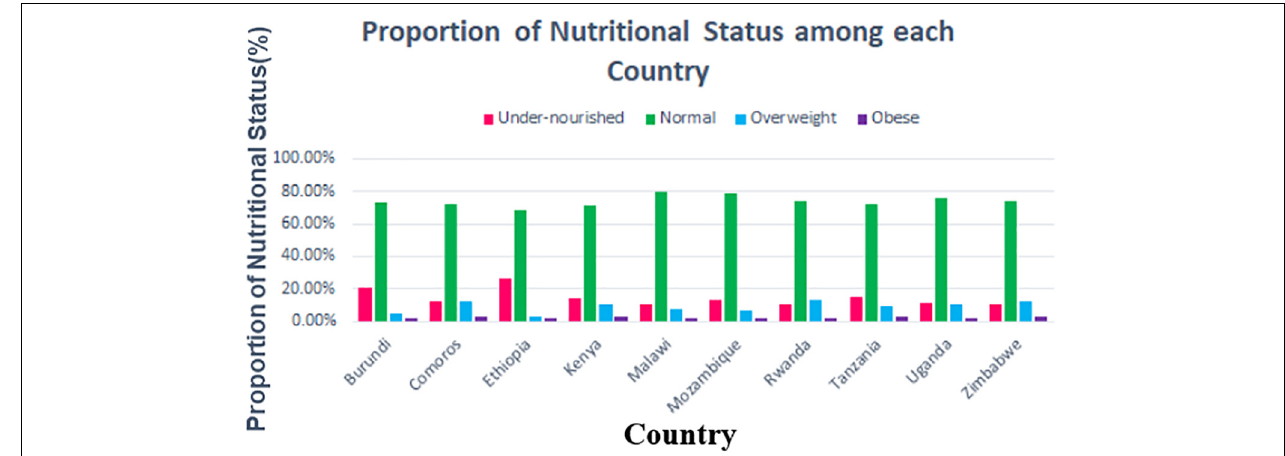
FIGURE 3 | Proportion of nutritional status among adolescent girls in East African Countries from 2010 to 2016.